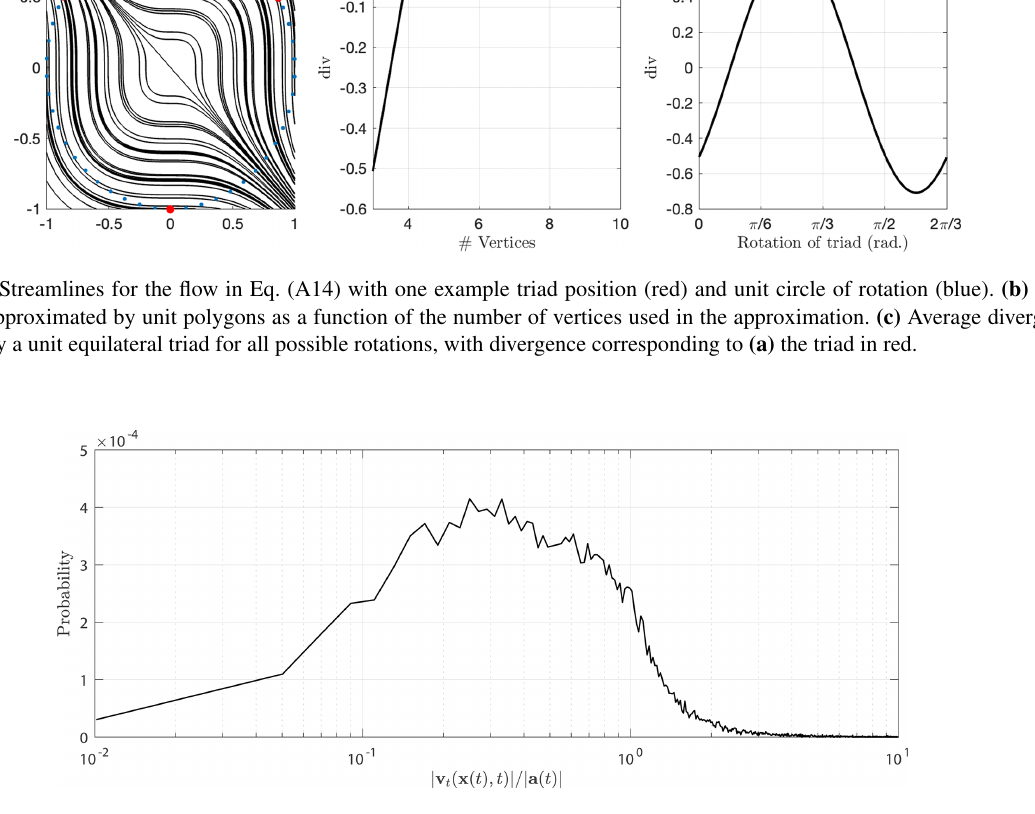
Figure A7. Example assessment of the slowly varying assumption of Arctic sea ice velocities from Polar Pathfinder Daily 25km EASE-Grid Sea Ice Motion Vectors, Version 4. | v t ( x (t),t) | / | a (t) | calculated from 50d of gridded sea ice trajectories surrounding the analysis in 2017 shown in Fig.